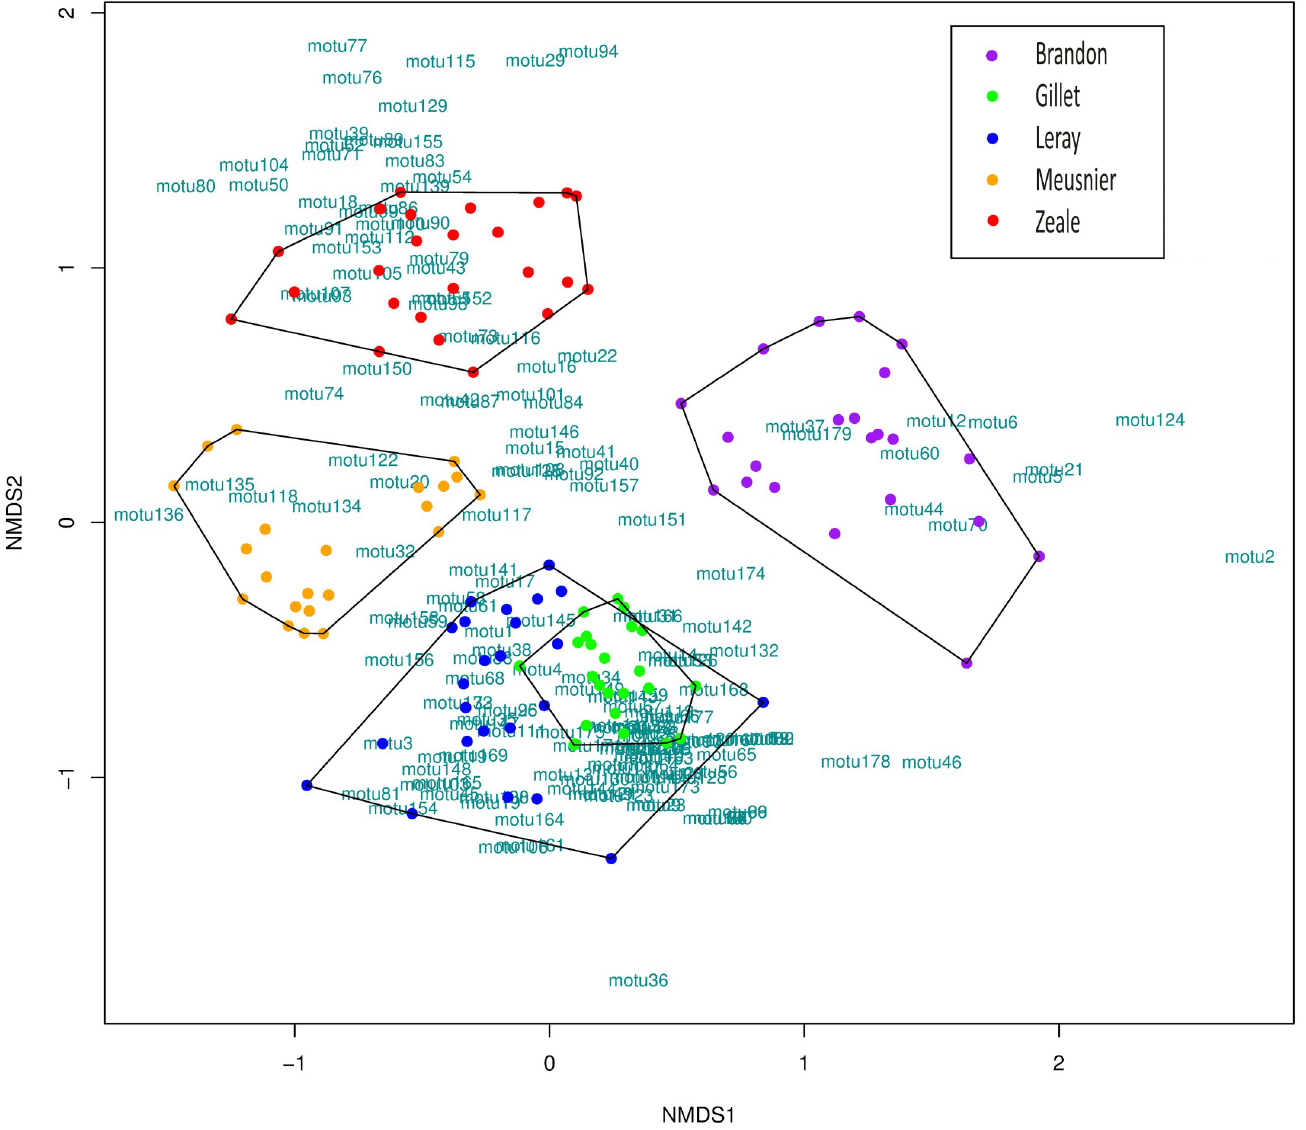
Fig 5. NMDS ordination of samples. Stress = 0.193; k = 2; non-metric fit R 2 = 0.963. Dots represent individual desman samples and colours different primer sets. OTUs are represented with green letters. More distant dots indicated a more different prey composition.